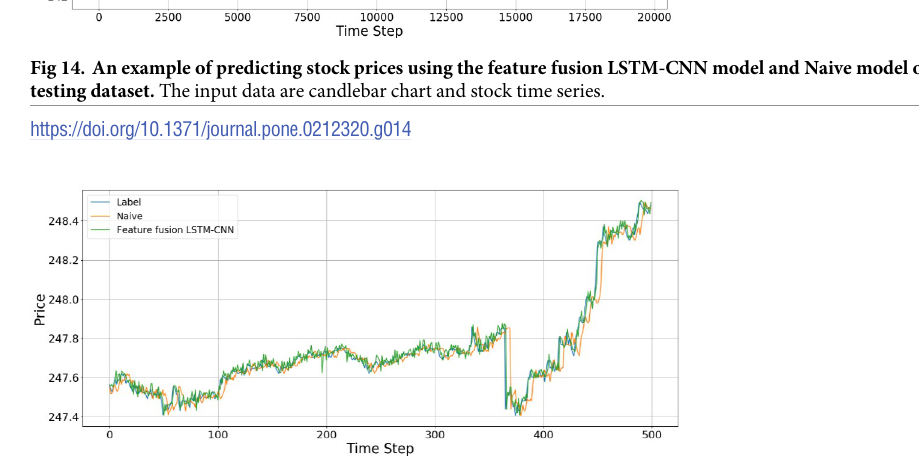
Fig 15. An example of predicting stock prices using the feature fusion LSTM-CNN model with a test dataset of between 0 and 500 data points. The input data are candlebar chart and stock time series.